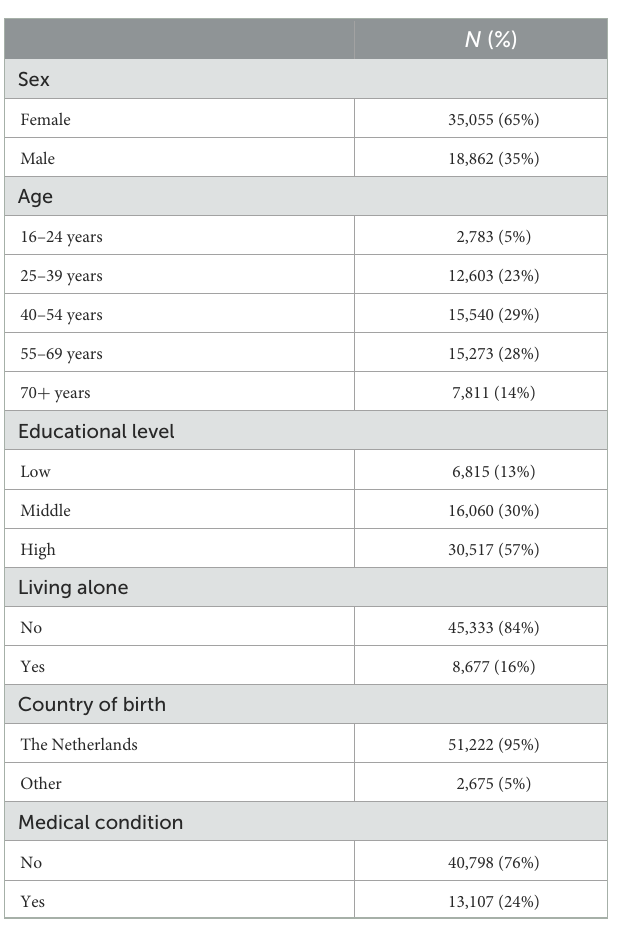
TABLE 2 Participants’ demographic characteristics ( N = 54,010 ∗